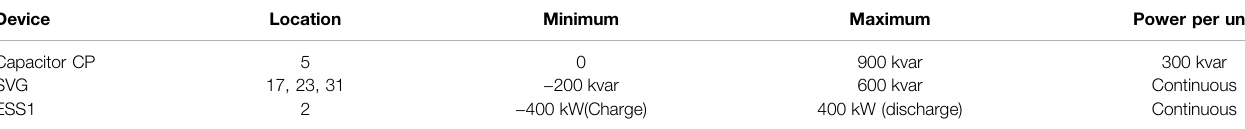
TABLE 1 | Parameters of adjustable device.